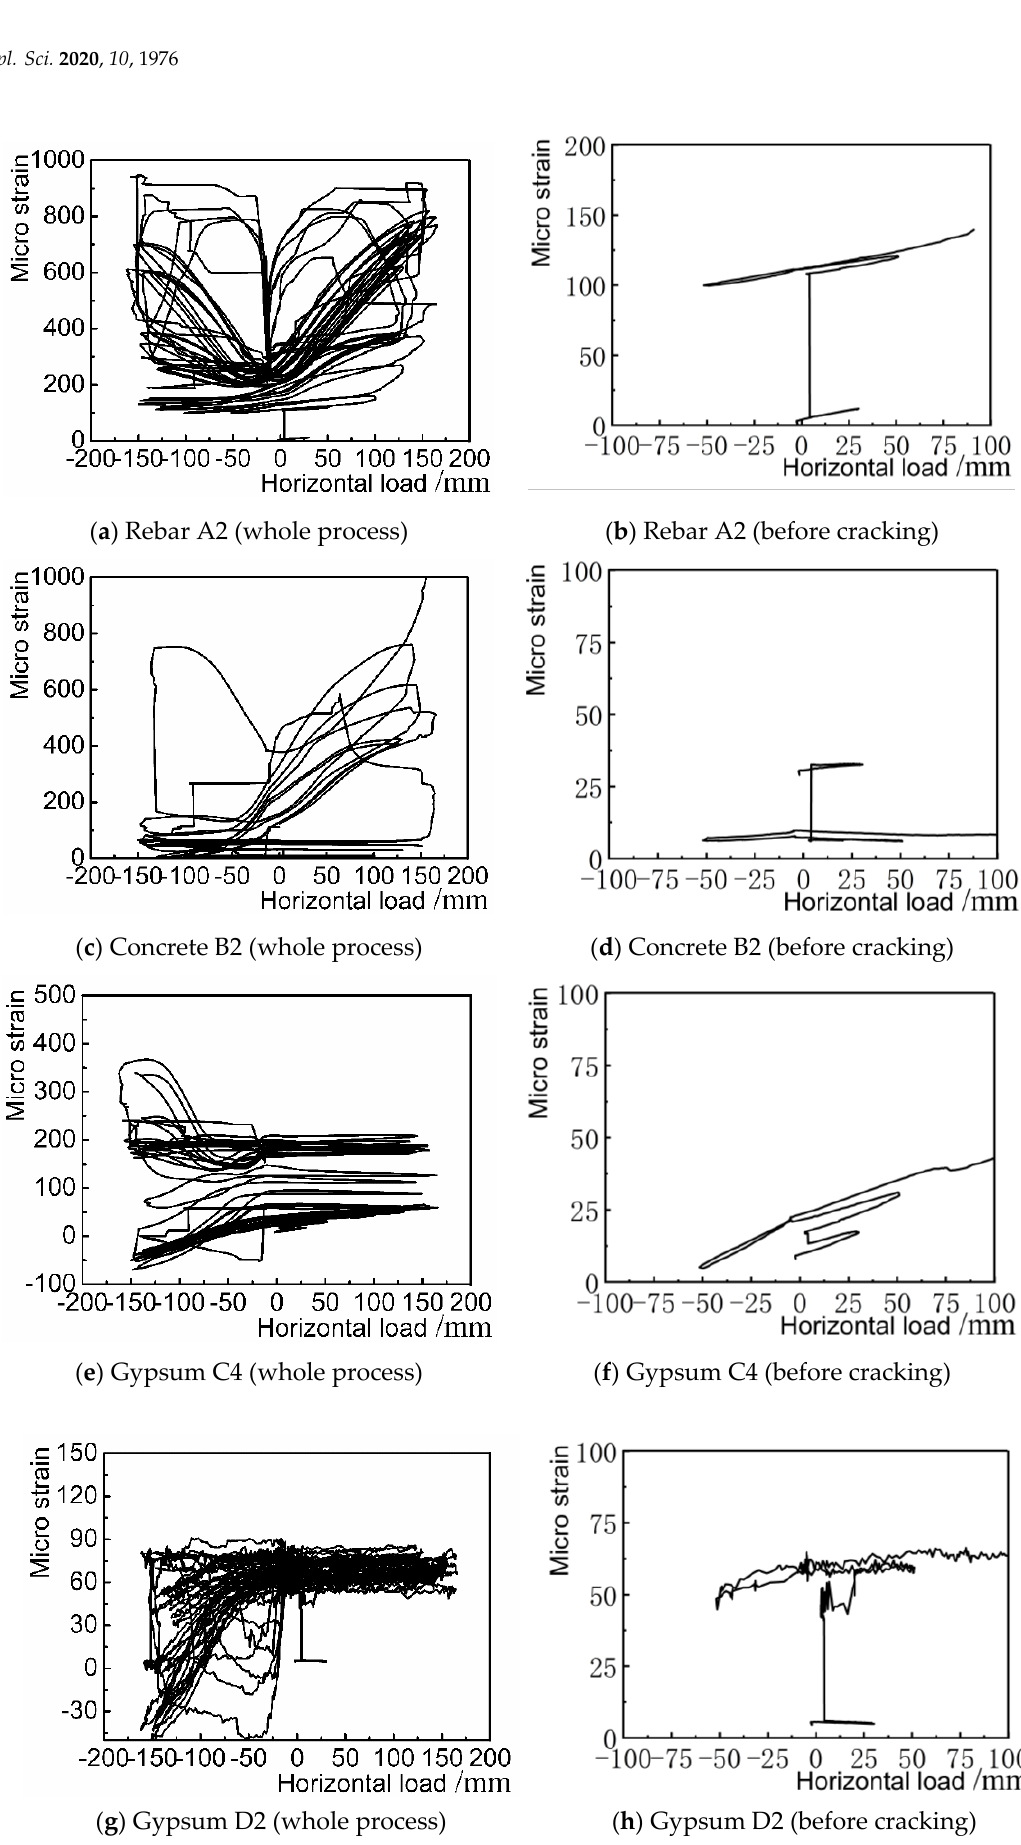
Figure 8. Load-strain curves.